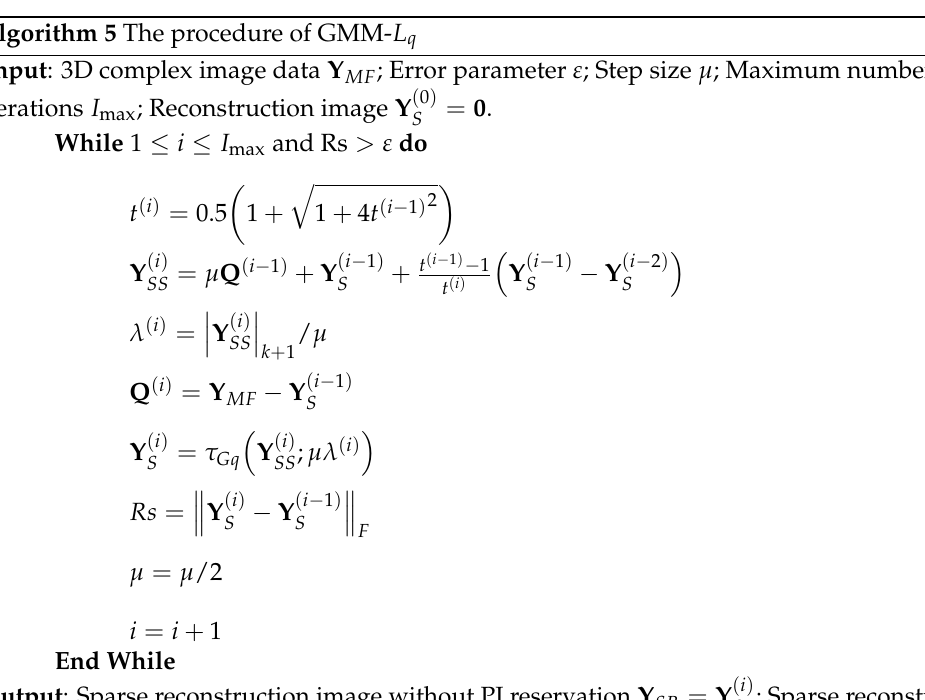
Algorithm 5 The procedure of GMM- L